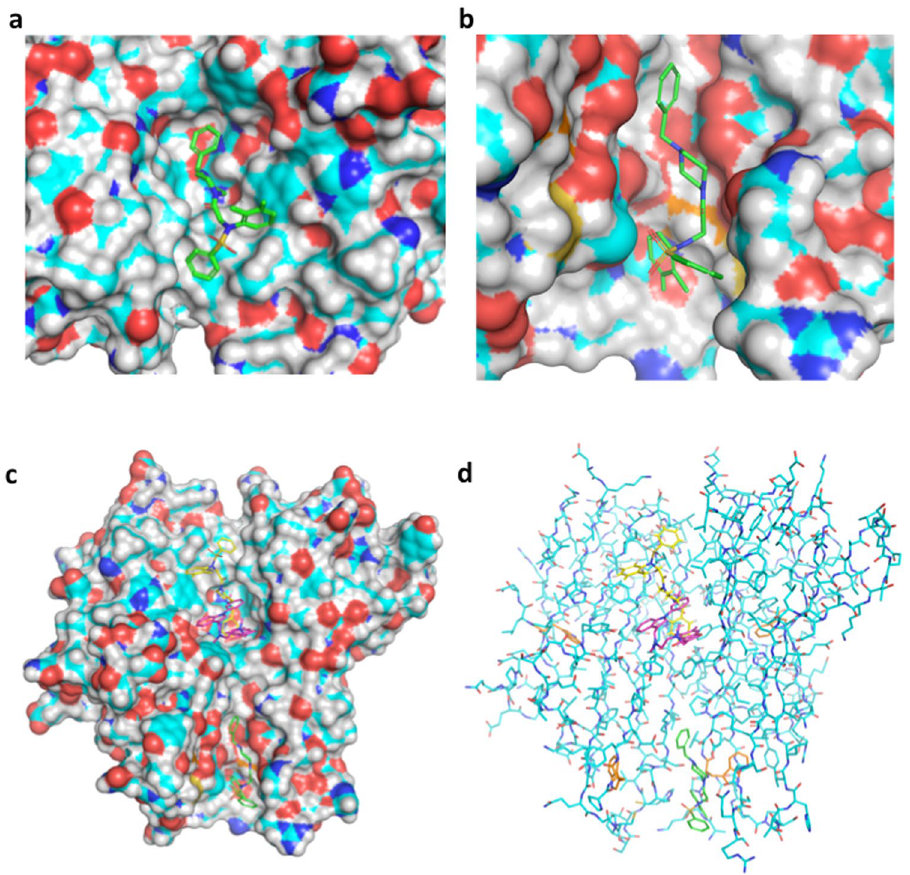
Figure 3. ( a ) Illustration of the top scoring binding mode of compound 1 with Surflex-dock in the TNF α binding site defined for the study (PDBID:2AZ5). ( b ) Alternate binding mode of compound 1 (green) predicted using Surflex-dock on the surface of TNF α dimer. Tryptophan residues are displayed in orange. ( c ) Secondary pocket on the structure of human dimeric TNF α . ( d ) Dual binding of compound 1 (yellow and green) predicted with Surflex-dock on the surface of the TNF α dimer co-cristallized with SPD304 displayed in purple (PDB ID: 2AZ5). Tryptophan residues are displayed in